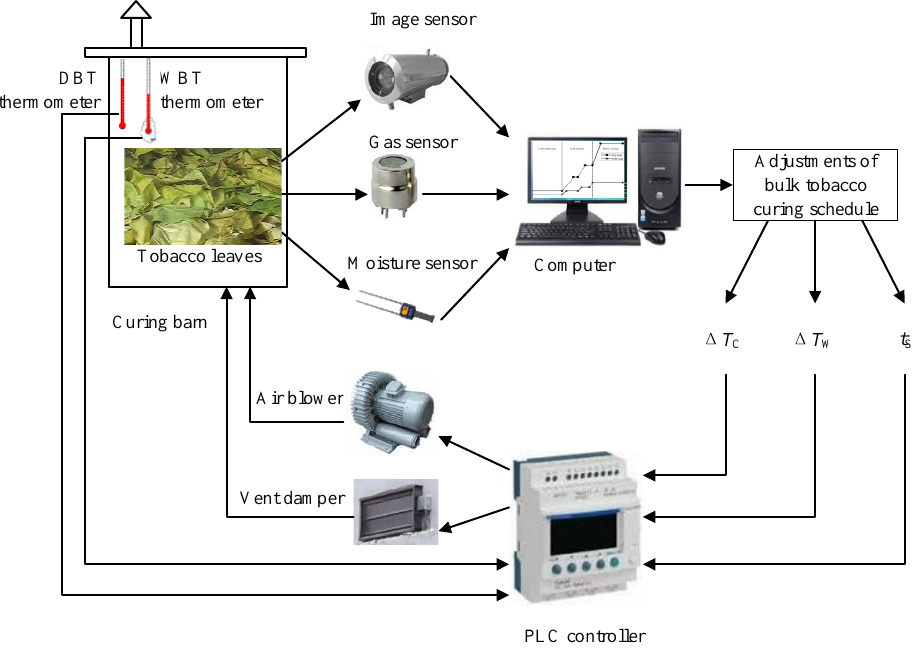
Figure 1. Framework of the proposed intelligent control method for bulk tobacco curing schedule.